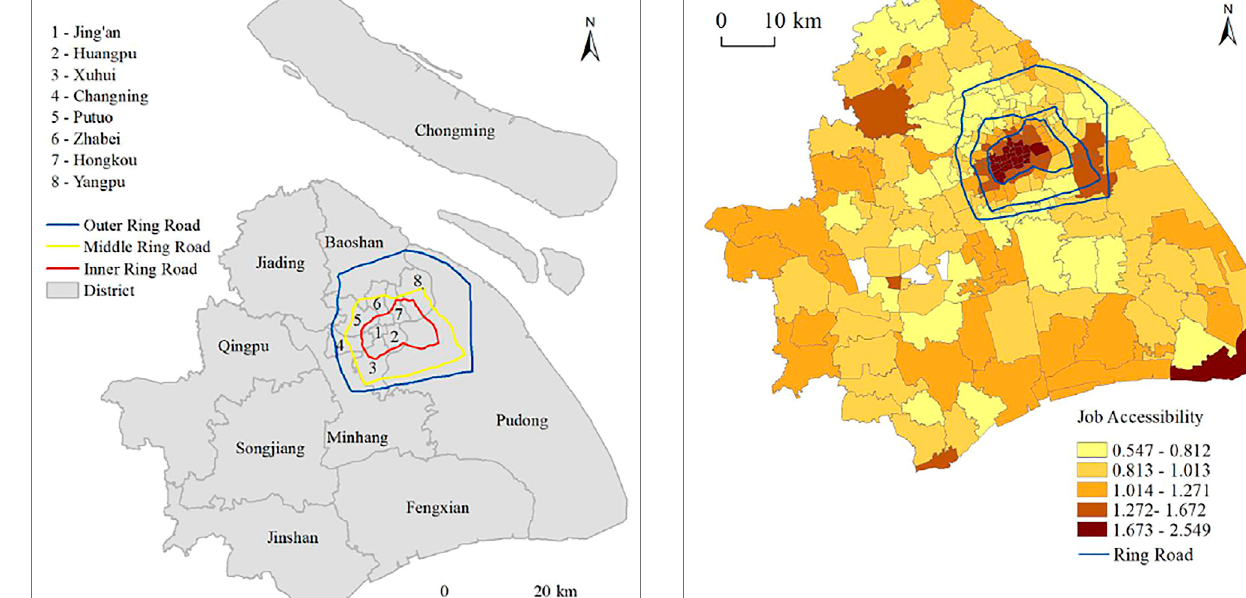
FIGURE 2 | Job accessibility of Shanghai at sub-district